Question: Reading the figure, is the described quantity rising or falling?
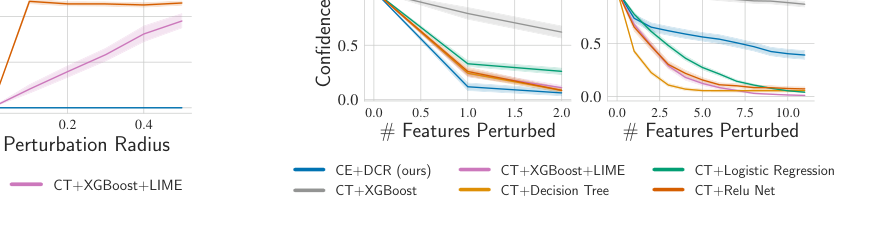
Answer: decreasing